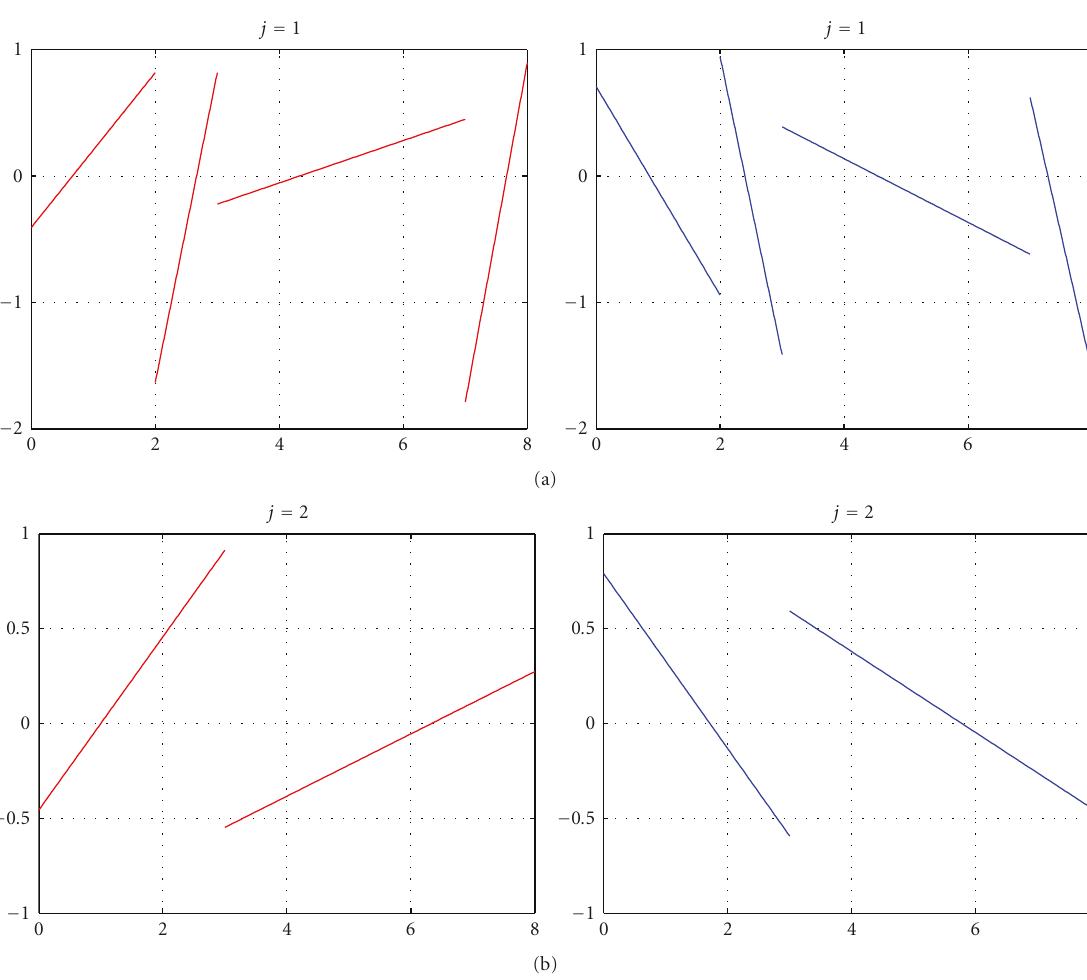
(graphs (a)), j = 1 (graphs (b)) and j = 2 (graphs